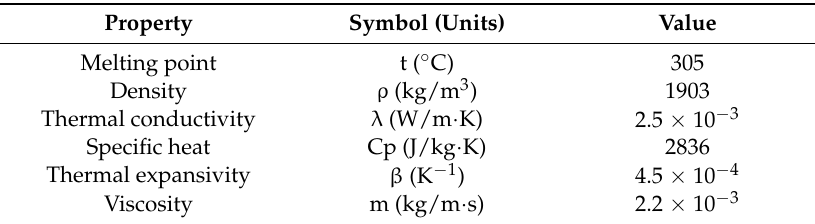
Table 2. NaNO 3 properties